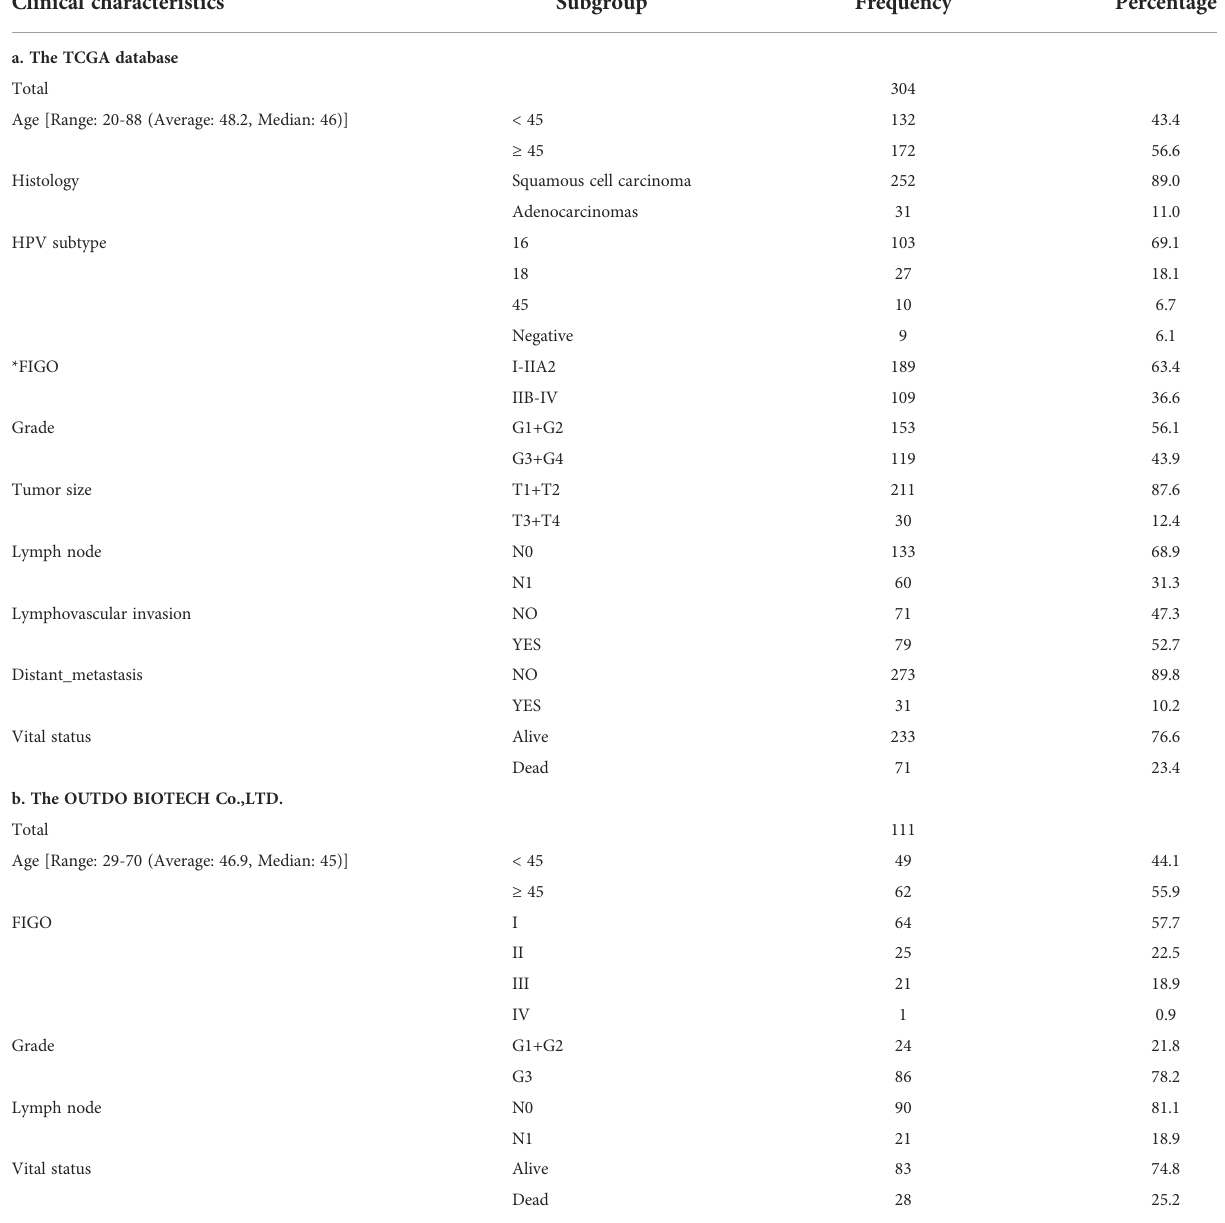
*FIGO, Five samples descripted as FIGO stage II, which was classi fi ed as ≤ IIA2 in this study. FIGO, The International Federation of Gynecology and Obstetrics p values < 0.05 are highlighted as the bold